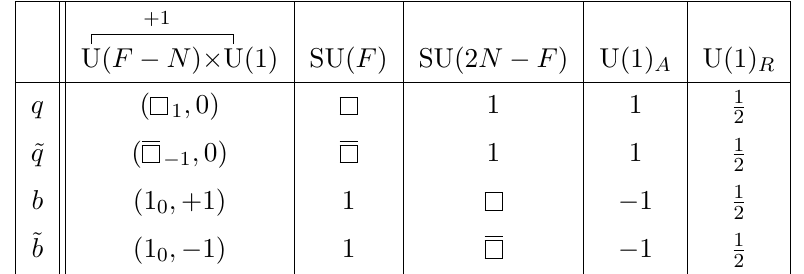
Table 5 . The mirror magnetic description dual to table 4. If the RG flow on the magnetic side corresponds to the electric one, this is also dual to the 3d N = 4 SU( N ) SQCD with N < F < 2 N flavors. In this table, we used our normalization of the U(1) ⊂ U( ˜ N ) charge for